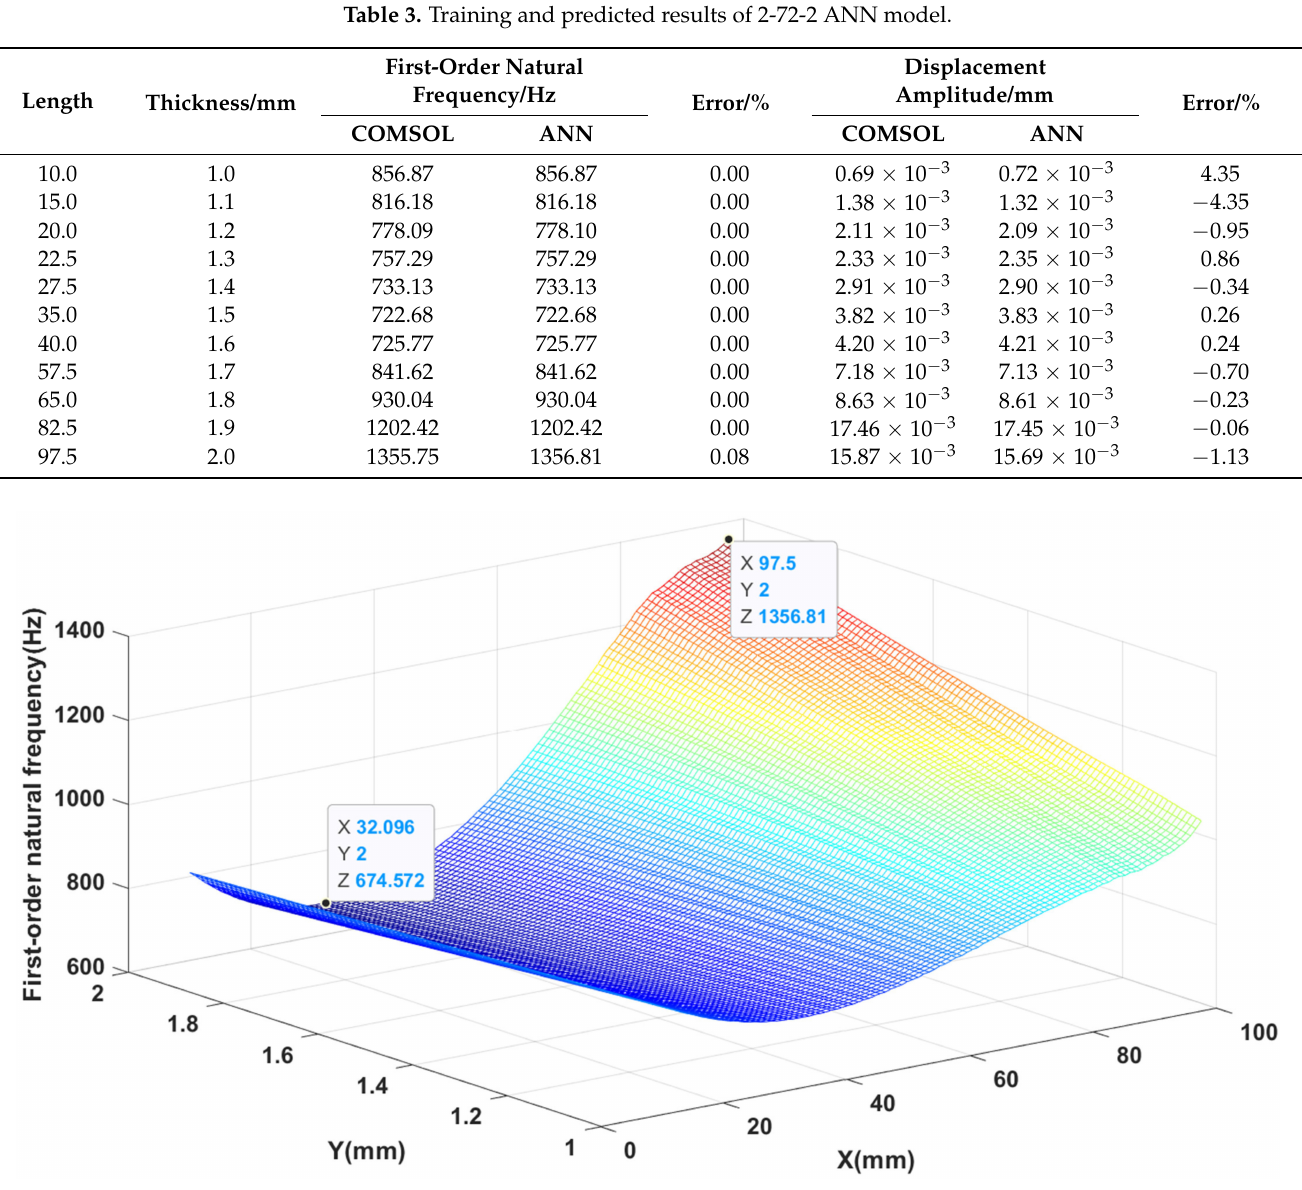
Figure 4. The variation of first-order natural frequency with side length and